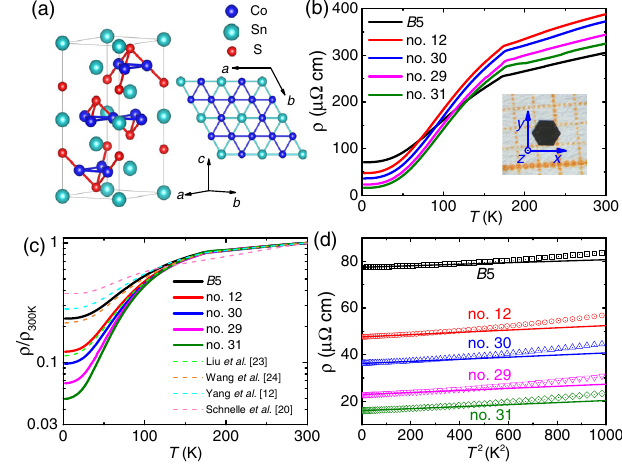
FIG. 1. Crystal structure, resistivity, and sample-dependent disorder. (a) Crystal structure of Co 3 Sn 2 S 2 . (b) Temperature dependence of resistivity at zero field in five samples. The residual resistivity ratio (RRR) ranges from 4 to 21. The inset shows an as-grown hexagonal-shape sample with a typical dimension of 1 . 3 × 1 × 0 . 02 mm 3 . The orientations of x , y , 2¯1 ¯1 0 (cid:3) 01¯10 (cid:3) and z are defined as ½ , ½ , and [0001], respectively. (c) Comparison of resistivity, normalized to its room-temperature value between the samples used in this study and four previous reports. The previous RRR is comparable with the two dirtiest samples in this study. (d) ρ as the function T 2 in our samples. The prefactor of T -square resistivity is similar in all four samples grown from chemical vapor transport method, but the difference is residual resistivity leads to an upward